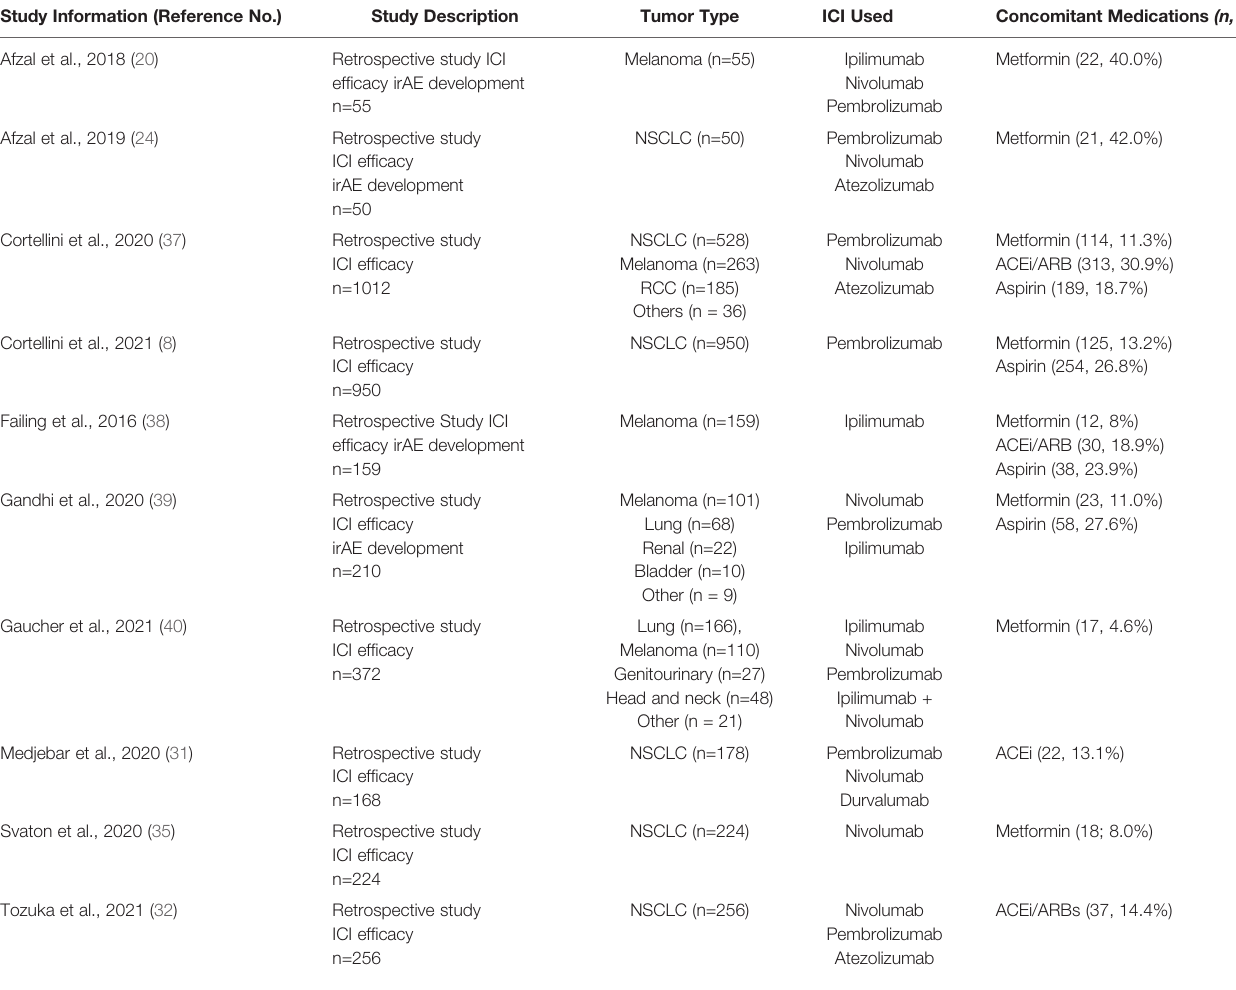
TABLE 1 | Retrospective clinical studies evaluating effect of metformin, ACEi/ARBs or aspirin on ICI ef fi cacy and toxicity in patients with advanced solid sumors. Study Information (Reference